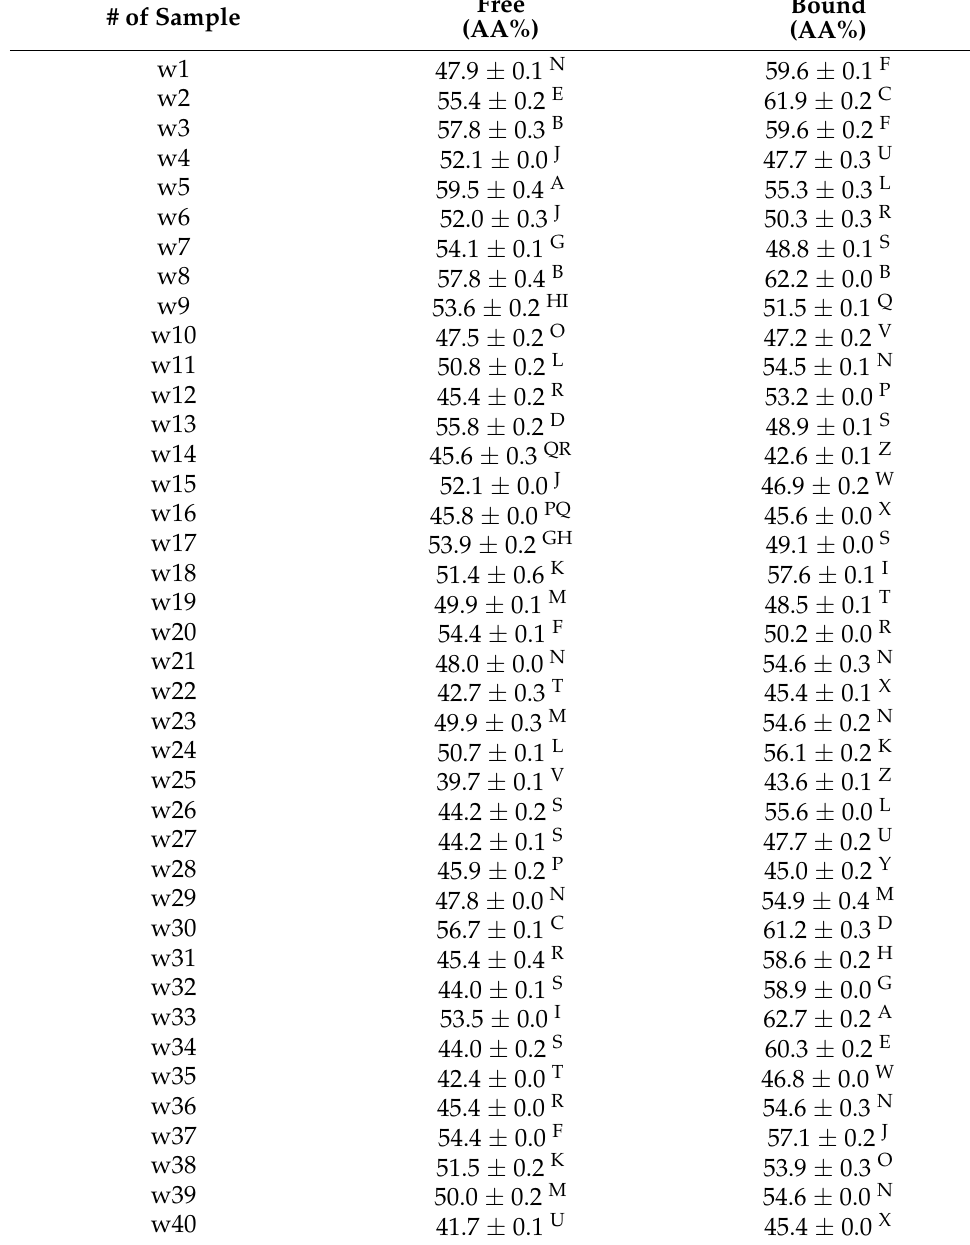
Table 5. Antioxidant capacity (DPPH: radical scavenging capacity) of purple wheat